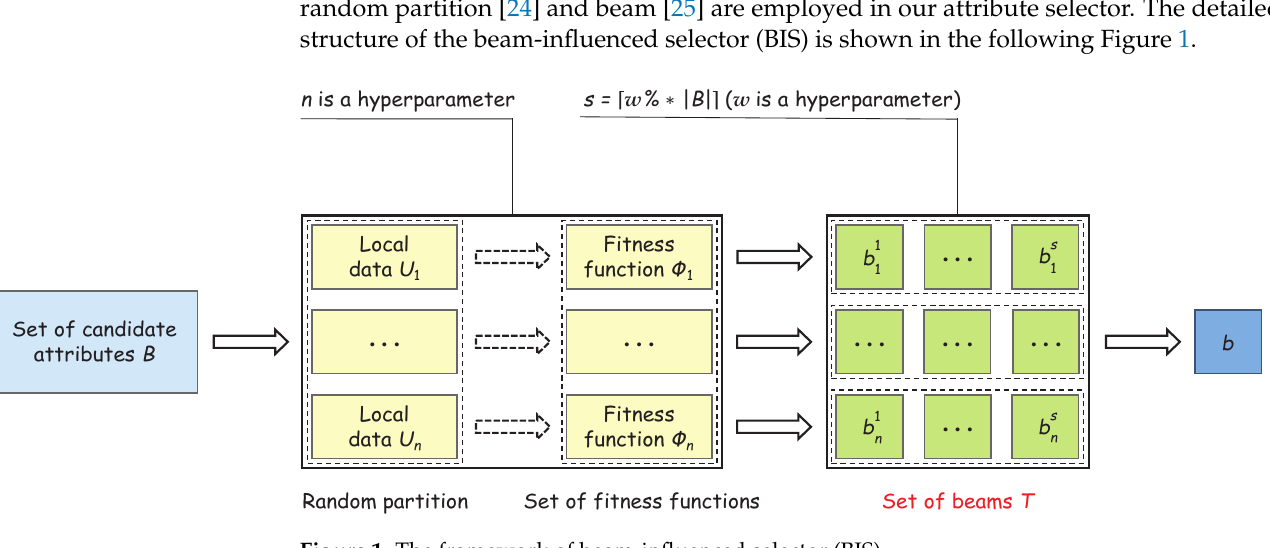
Figure 1. The framework of beam-influenced selector